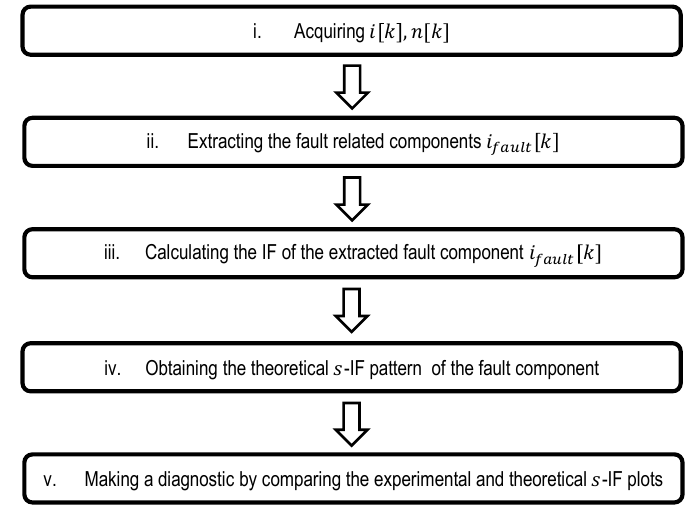
Figure 1. Block diagram of the diagnostic methodology proposed in this